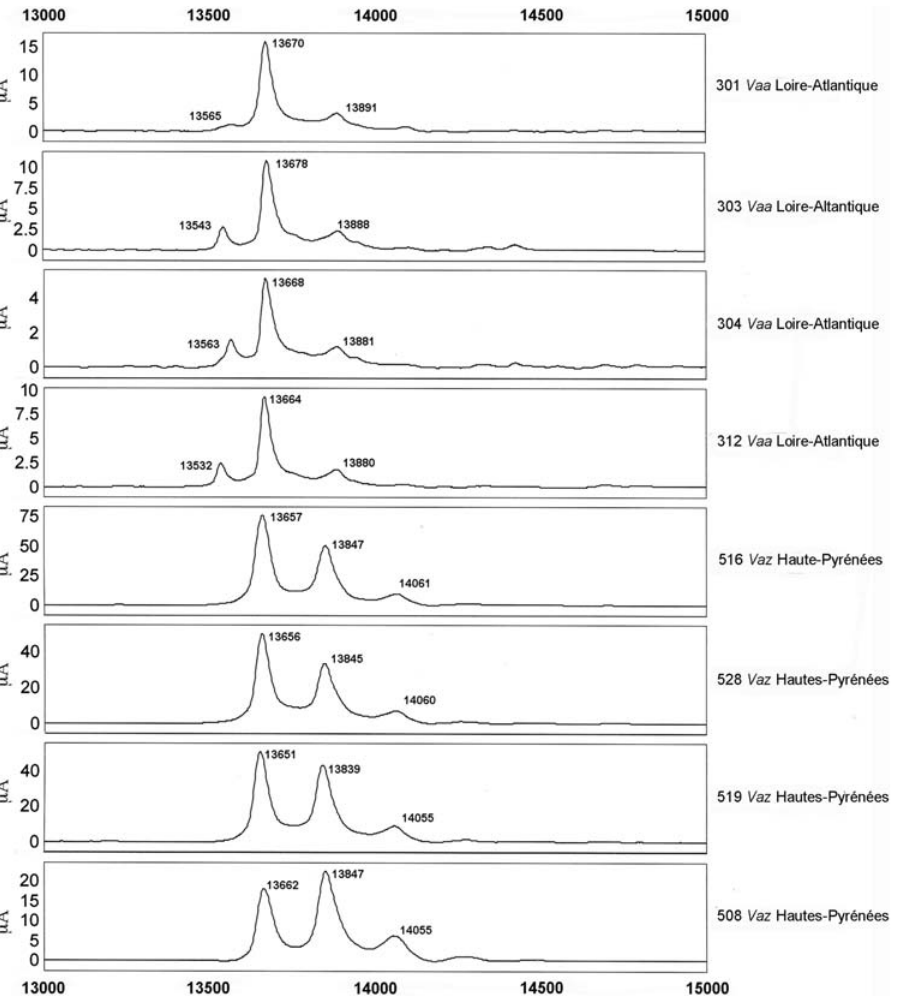
Figure 4. Selective capture of PLA 2 using SELDI ProteinChip Array. Individual venoms (2.5 m g) were applied to the surface of a WCX2 ProteinChip as described in the Methods section. Unbound proteins and interfering substances were washed away and matrix was added and allowed to dry. The captured proteins were detected using surface enhanced laser desorption/ionization (SELDI) time-of-flight mass spectrometry. Normalised mass (m/z) for each peak (in Daltons (Da)) is demonstrated on the X-axis, while intensity ( m A) is plotted on the Y-axis. m/z ratios from different spectra that are within 0.2% of each other are considered as potentially the same protein.